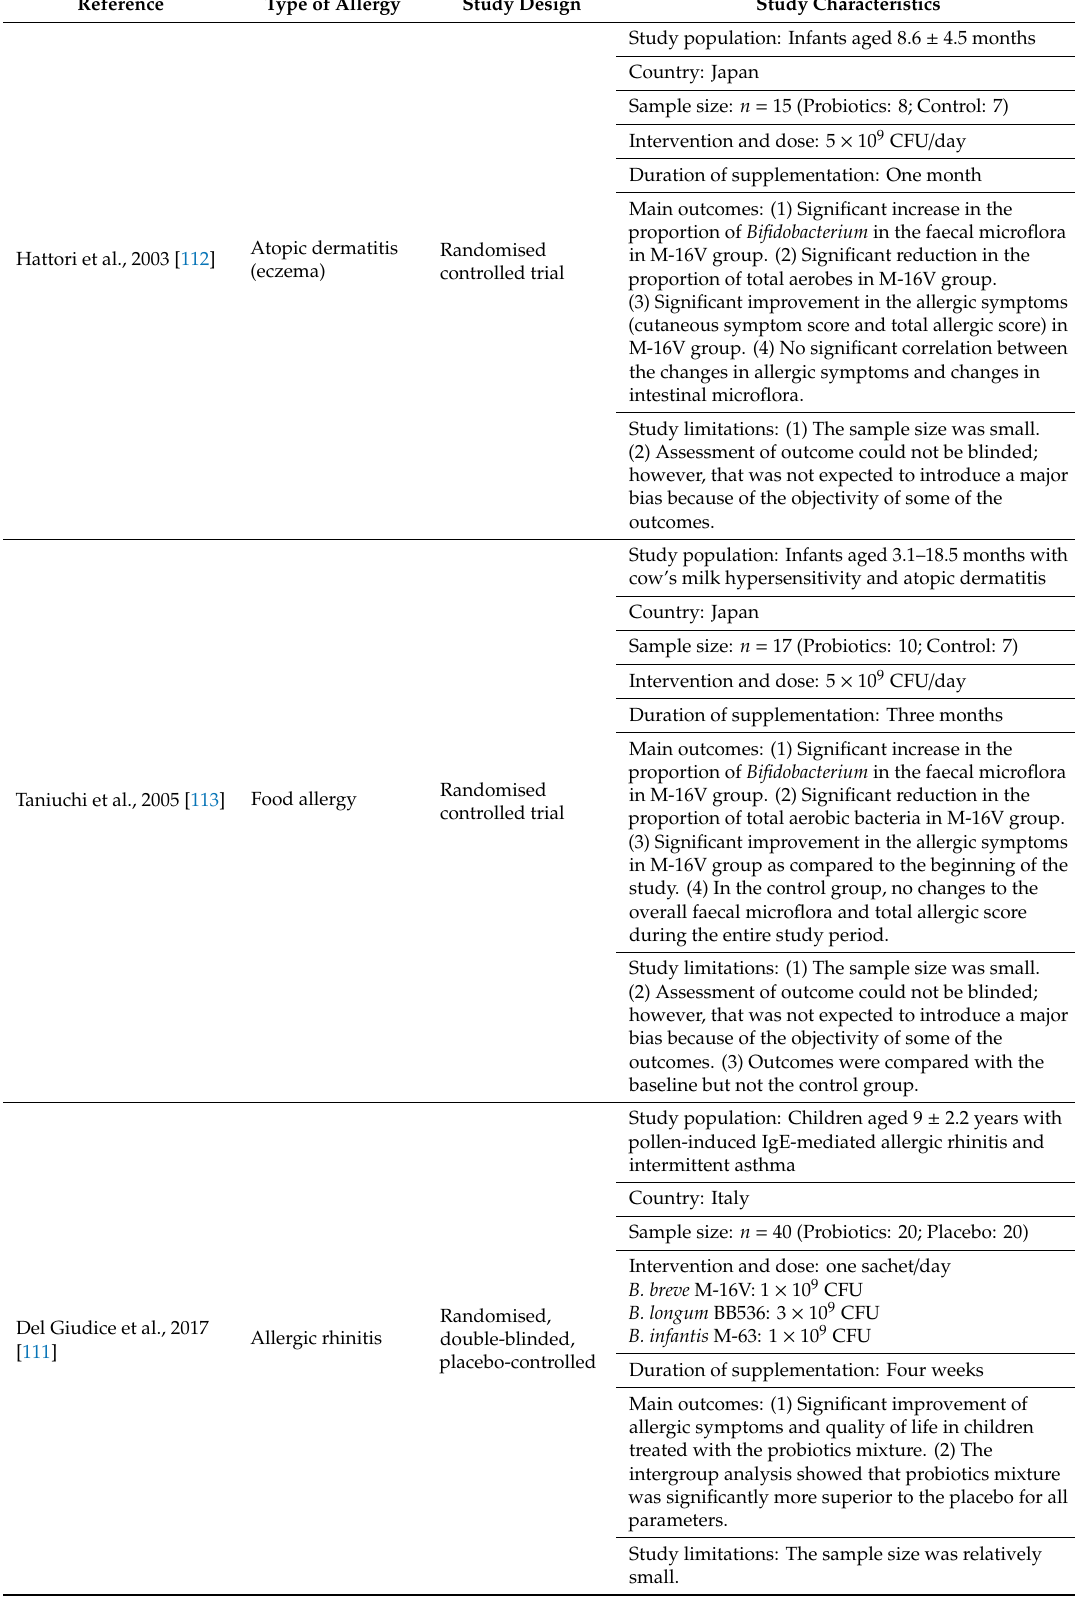
Table 2. Summary from clinical studies of the e ff ects of M-16V on allergic